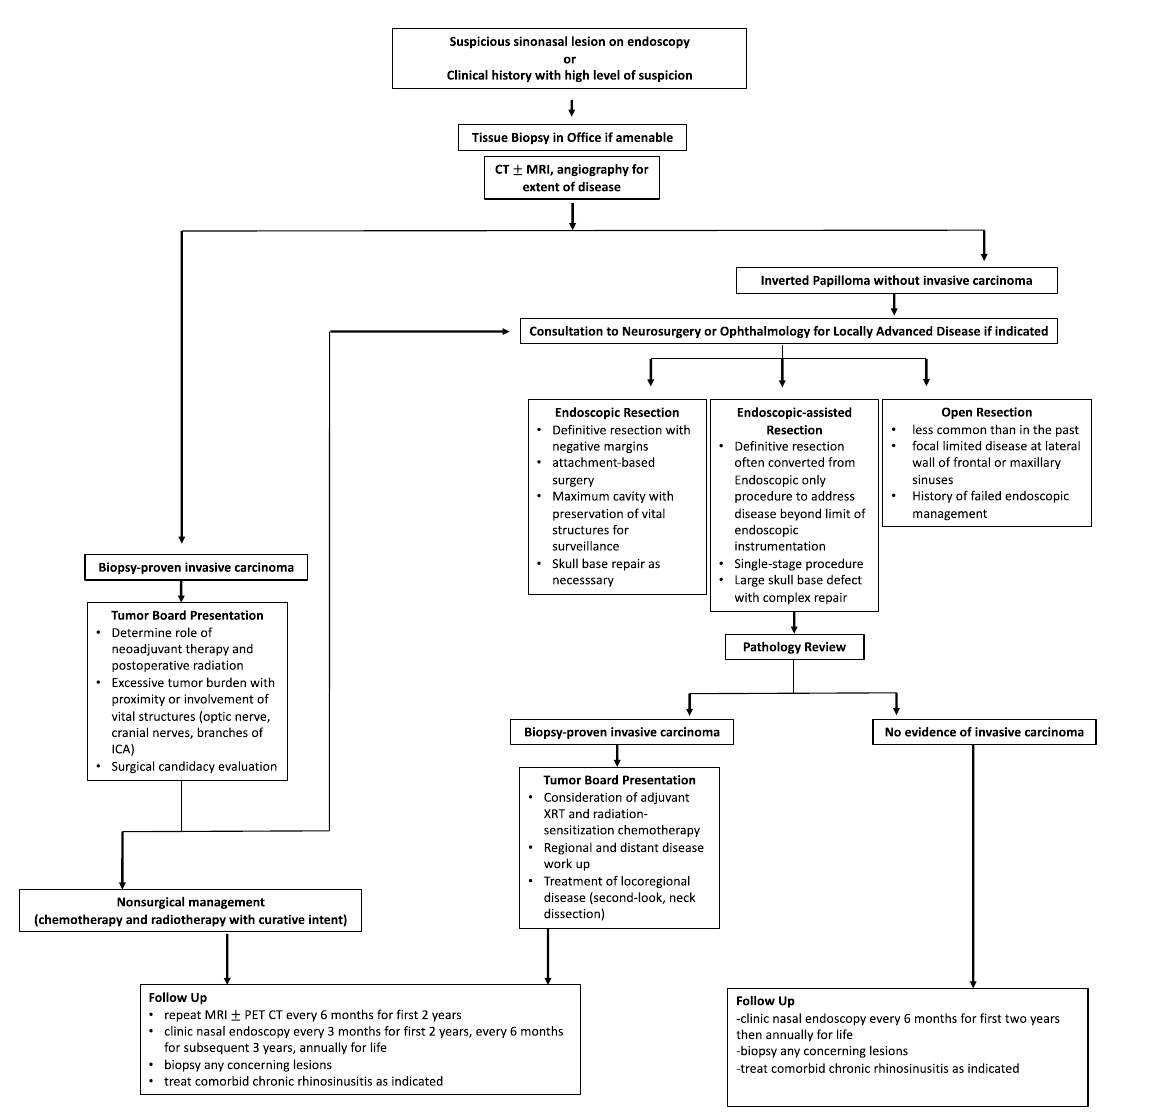
Figure 9. Treatment algorithm for the diagnosis, management, and surveillance of both IP and malignant SCC ex-IP.